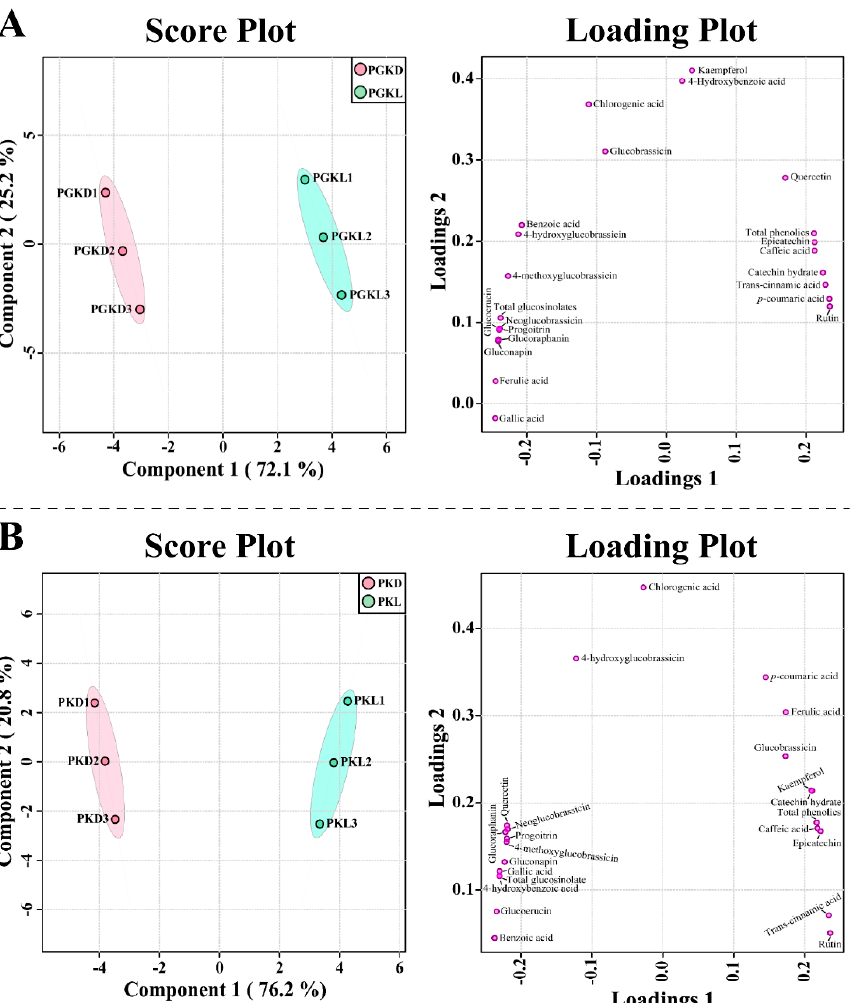
Figure 3. Score plots and loading plots of the principal component analysis (PCA) results acquired from 21 secondary metabolites from ( A ) PGK and ( B ) PK sprout grown under light and dark conditions.